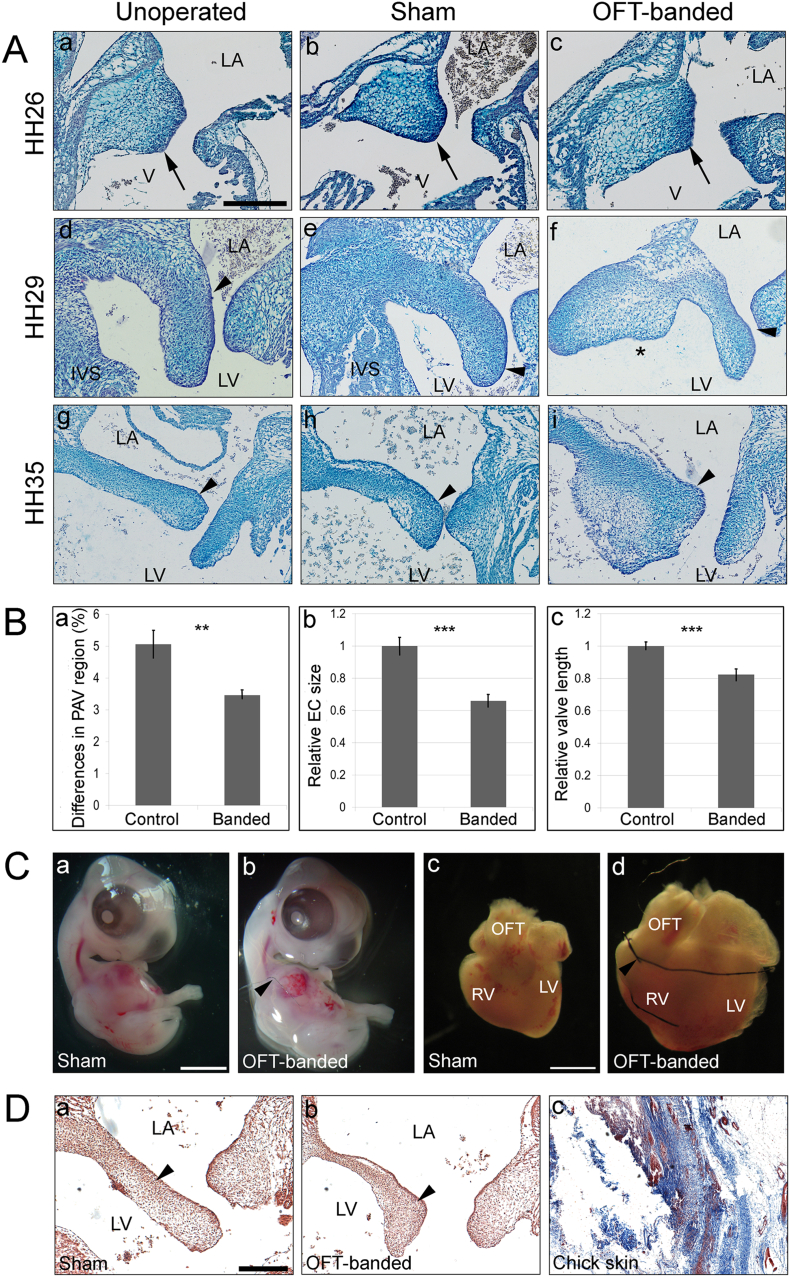
Defective mitral valve in OFT-banded hearts.A. Alcian blue stained sections from unoperated (a, d, g), sham (b, e, h) and OFT-banded (c, f, i) hearts at HH26 (n = 5 per group; a–c), HH29 (n = 31 for OFT-banded and n = 37 for controls; d–f) and HH35 (n = 7; g–i). Valve morphology at HH26 appeared comparable in all hearts (a–c; denoted by arrow). In OFT-banded hearts, defective primordial mitral valve appeared either smaller (arrowhead in f) or presented with nodular thickening (arrowhead in i) at HH29 and HH35 in comparison to controls (d, e, g, h; denoted by arrowhead). Asterisk in Af denotes the absence of the interventricular septum (IVS) in the OFT-banded hearts.B. Stereology revealed the primordial AV region was proportionally smaller in the OFT-banded hearts than controls at HH29 (a). Relative cushion area (b) and relative valve length (c) were smaller and shorter in banded compared to controls. Student's t-test (two-tailed). Values are mean ± s.e.m. (n = 7 for OFT-banded and n = 12 for controls) (**P < 0.01; ***P < 0.001).C. Representative images of sham (a) and OFT-banded embryos (b) at HH29, showing the size is similar between both groups. OFT-banded hearts (d) appeared to be larger than the controls (c) at HH29. Arrowhead denotes the ligature around the outflow tract region in the banded hearts.D. Histological analysis using Masson's Trichrome staining revealed no fibrosis (arrowhead indicates blue staining absent) in the primordial MV septal leaflets at HH35 between sham (a) and banded hearts (b) (n = 5). Chick skin shown as a positive control (c). LA, left atrium; LV, left ventricle; OFT, outflow tract; RV, right ventricle; V, ventricle. Scale bars: 250 μm for Aa-i, 1000 μm for Ca-d, 80 μm for Da-c. (For interpretation of the references to colour in this figure legend, the reader is referred to the web version of this article.)